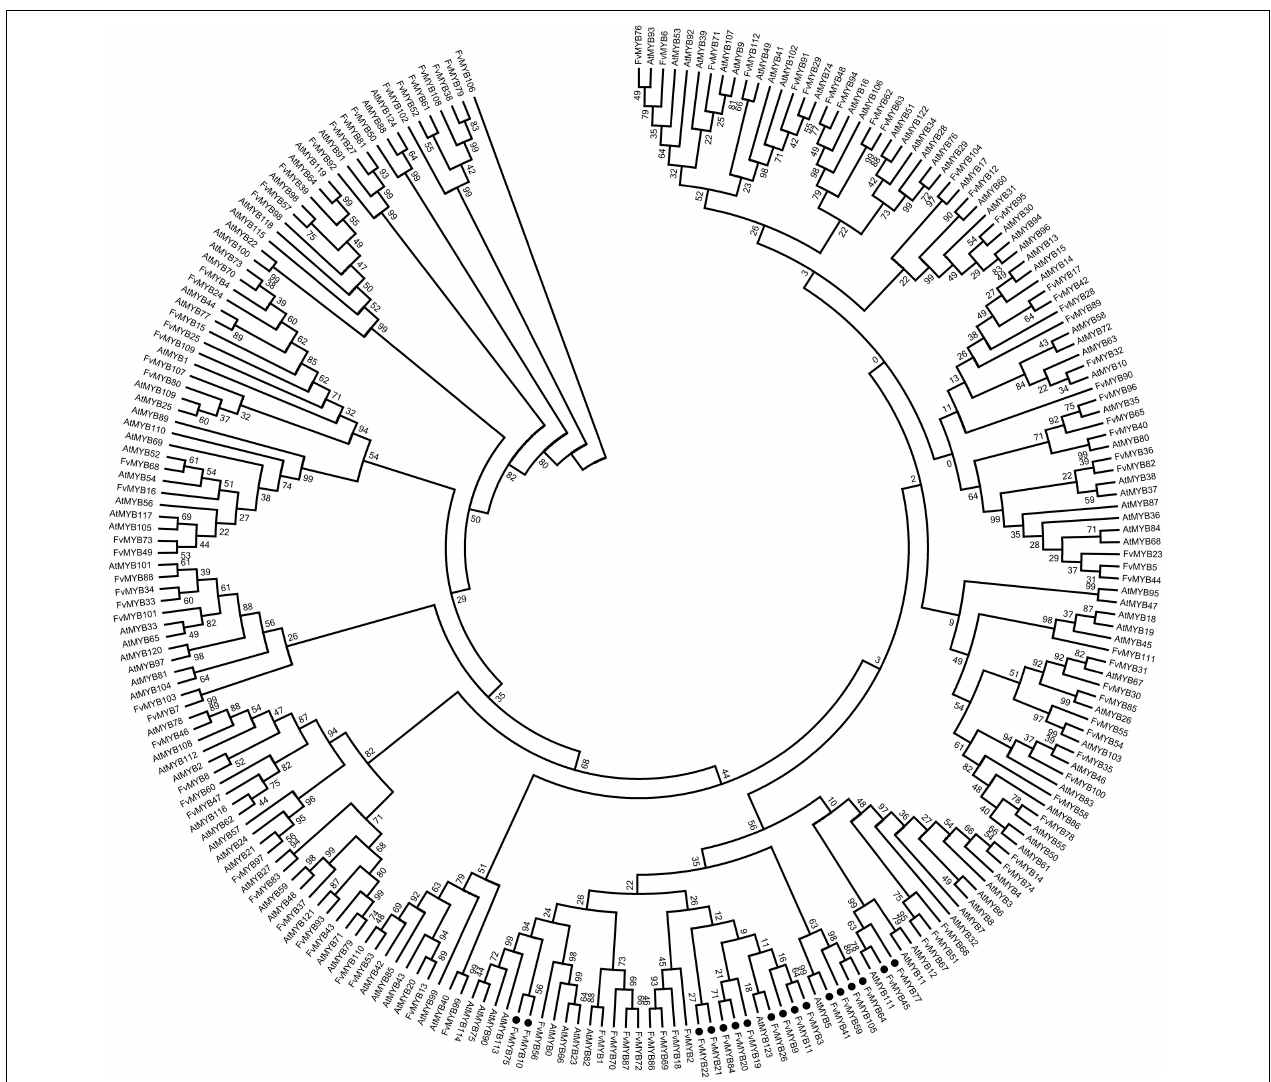
FIGURE 1 | Phylogenetic analysis of R2R3-MYB proteins of Arabidopsis and woodland strawberry. The numbers above the line are the bootstrap values. Black solid circles indicate those related to flavonoid biosynthesis.